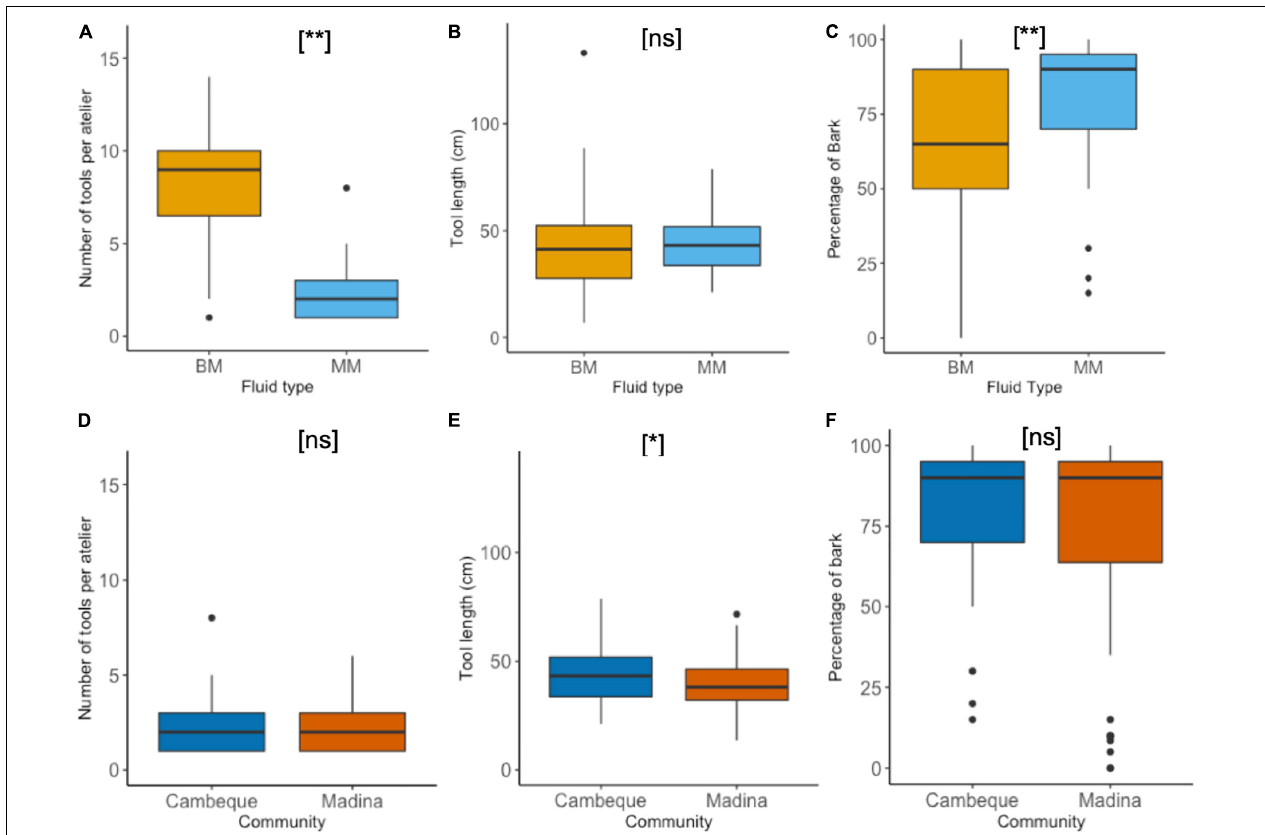
FIGURE 4 | Honey dipping tool characteristics. Tools per atelier, tool length (cm) and percentage of bark remaining, compared between fluid types BM and MM at Cambeque (A–C) and between two neighbouring communities, Cambeque and Madina, exploiting MM (D–F) . Boxplots indicate upper and lower quartile; thick horizontal lines represent median. Maximum and minimum data range indicated by whiskers; black dots show individual outliers. P -values are indicated by [ns] – p > 0.05; [*] – p ≤ 0.05; [**] – p ≤ 0.01.